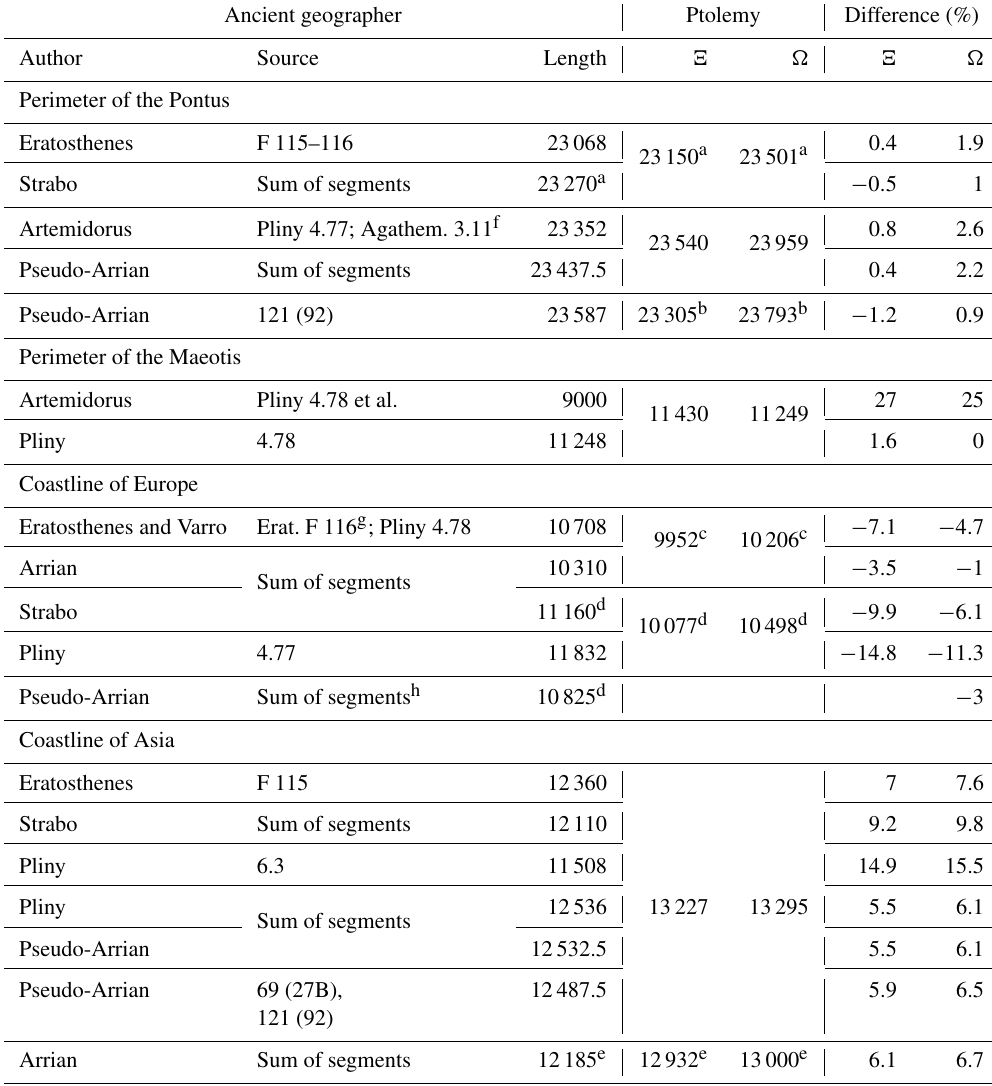
Table 1. Length of the coastlines of the Pontus and the Maeotis according to Ptolemy and other ancient geographers (in stades). Ptolemy’s data are given for both recensions ( (cid:52) and (cid:127) ). The “Difference” columns show how much Ptolemy’s data differ from the other geographers’ estimates (expressed as a percentage of the latter). Some coastlines are measured differently on different lines, as marked by the indices attached to the distance values: “a” refers to values measured without the interval between Panticapaeum and Achilleion; “b” refers to values measured without the width of the Cimmerian Bosporus between Achilleion and Porthmion and the Porthmion–Myrmekion stretch; “c” refers to values measured from the Sanctuary of Zeus/Artemis to Panticapaeum; “d” refers to values measured from the Sanctuary of Zeus/Artemis to Myrmekion; and “e” refers to values measured from the Thracian Bosporus to Korokondame. On all other lines, the coastlines are measured without